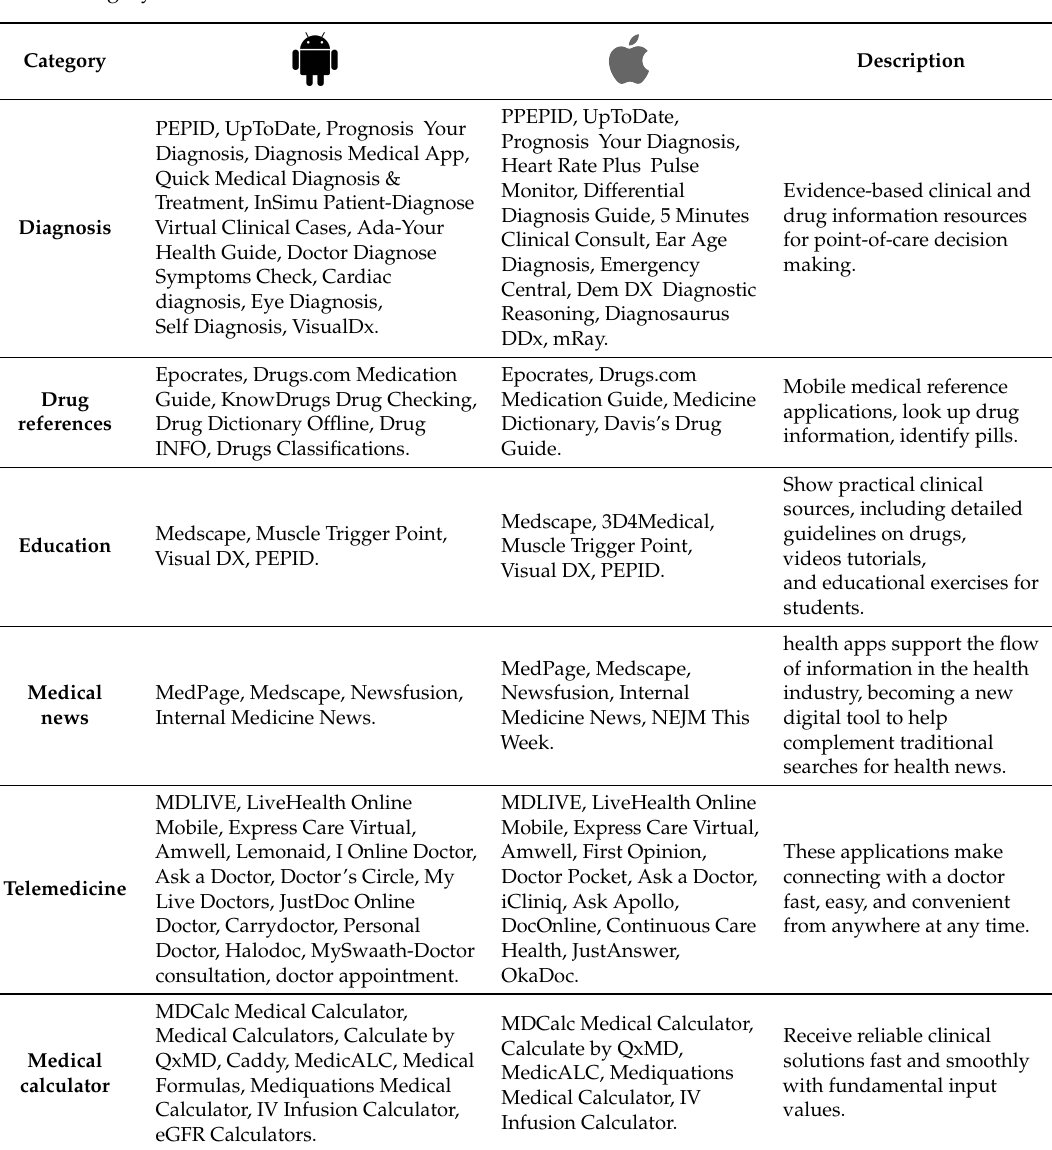
Table 8. Classification of healthcare apps for academic purpose by category and a description for each